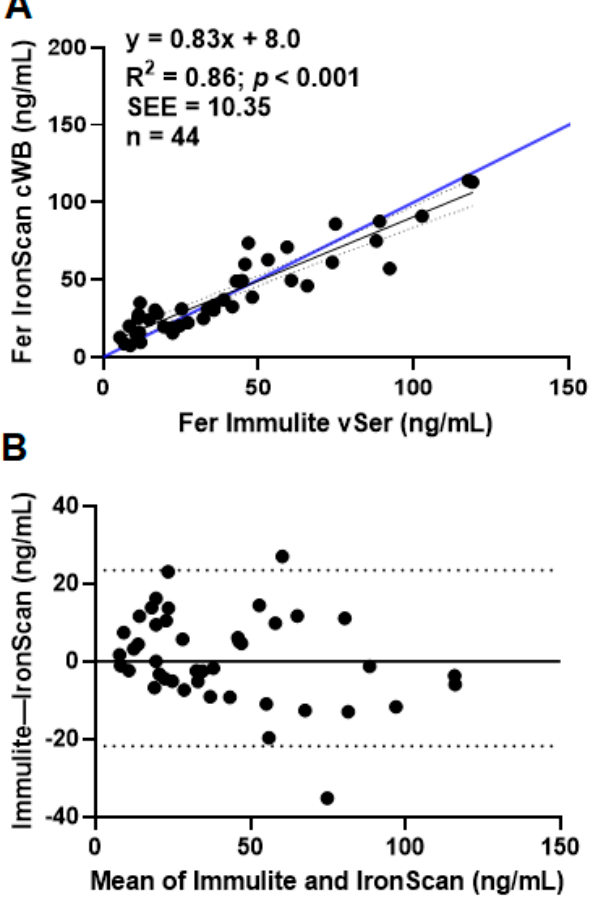
Figure 2. Comparison of ferritin (Fer) values from IronScan™ using capillary whole blood (cWB) versus Immulite 2000 Xpi using venous serum (vSer). ( A ). Regression analyses. ( B ). Bland–Altman plot. Dashed lines represent 95% confidence intervals around the slope (panel A ) or the mean (panel B ). Blue line represents the line of identity. Standard error of the estimate,